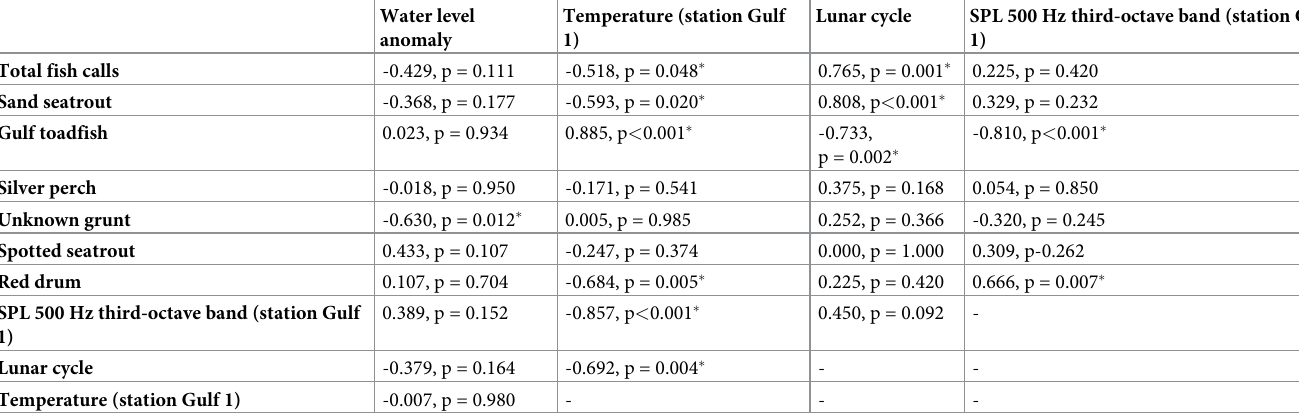
Table 8. Spearman’s rho correlations for station Gulf